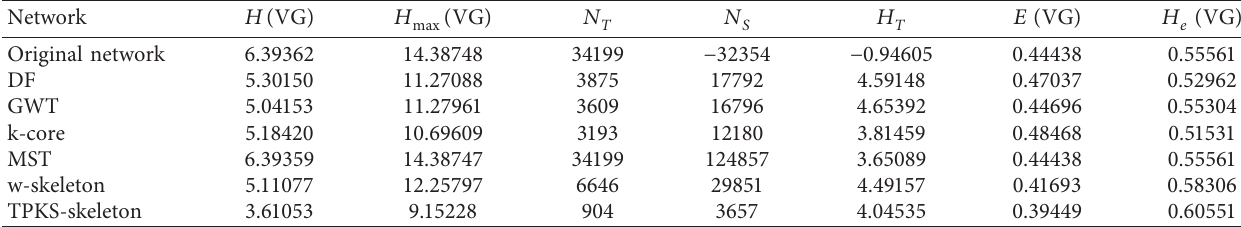
Table 6: Spatial information of different skeleton networks over the Voronoi diagrams.